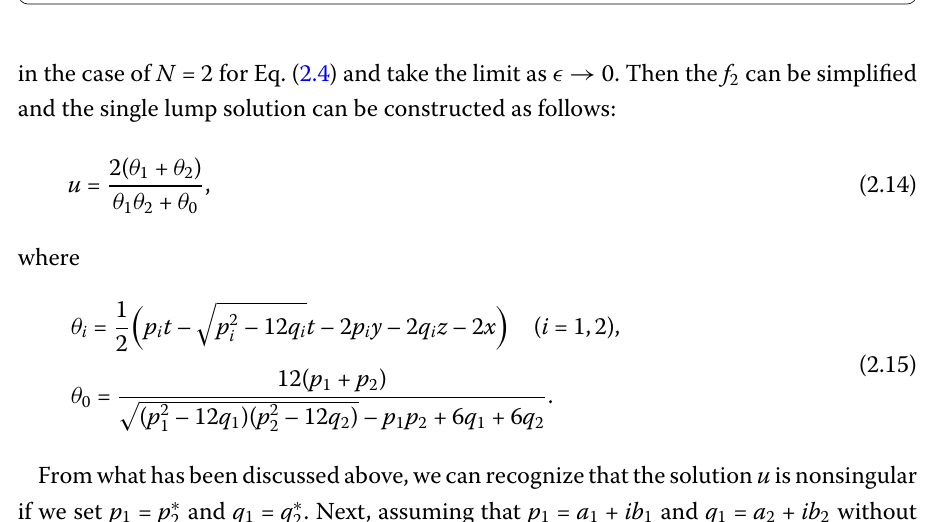
Figure 7 The interaction solution between two general breathers of Eq. (1.2) in the ( x , z ) plane with parameters constrained by Eq.